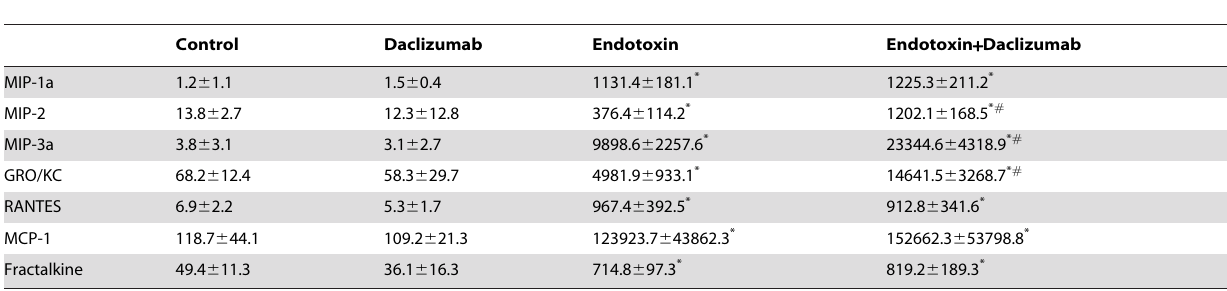
Table 3 . Chemokine concentration in the aqueous humors of the different study